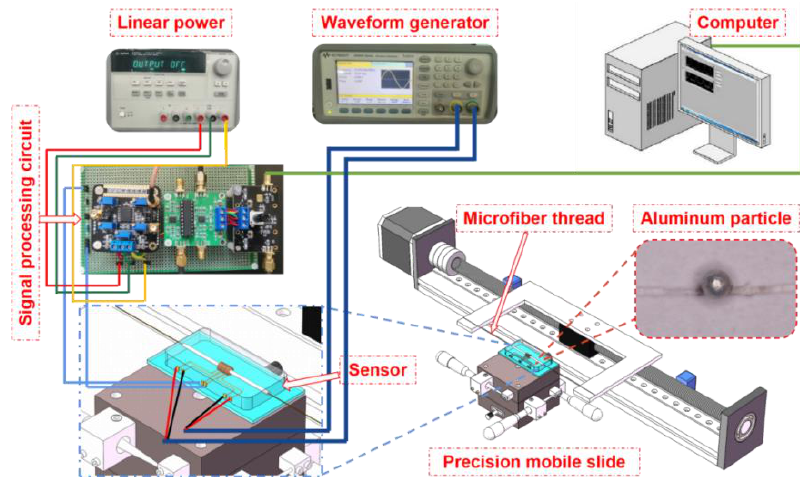
Figure 4. Sensor and experimental system.